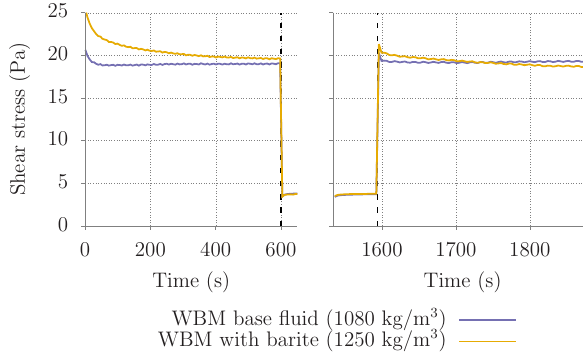
Figure 11: Measured shear stresses at a high shear rate of 1021 s −1 followed by a step change in shear rate to 5.1 s −1 (left), and the reverse step sequence from 5.1 s −1 to 1021 s −1 (right). The fluid is at rest at the very start of the measurement sequence ( t = 0